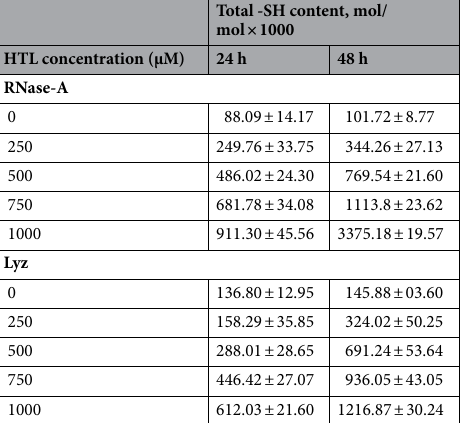
Table 1. Free sufhydryl content of HTL-modified proteins: Total free -SH content of HTL- modified RNase-A and Lyz taken at intervals of 24 h and 48 h.